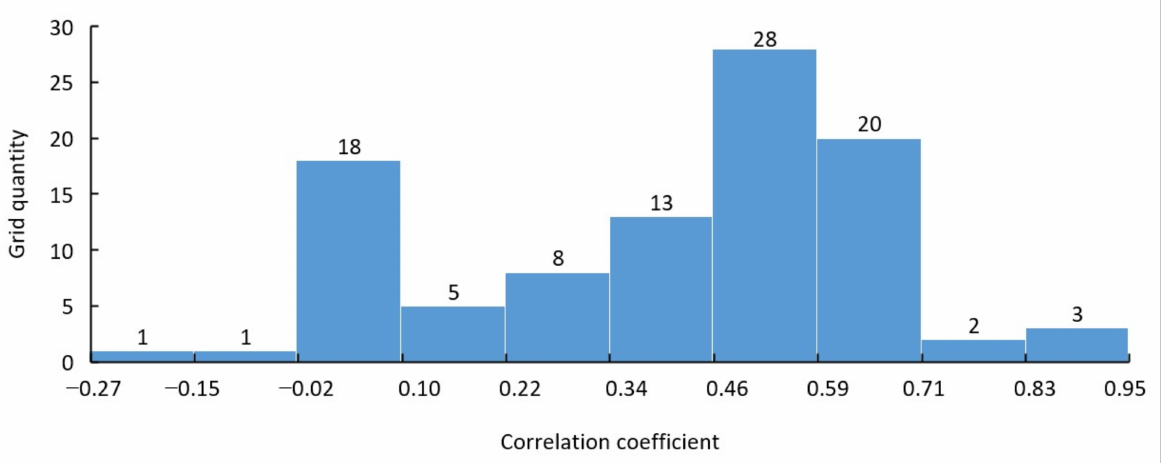
Figure 3. Frequency histogram of correlation coefficients between 10 cm soil moisture of simulation and observation in merged grids containing soil moisture stations of Jiangsu province.